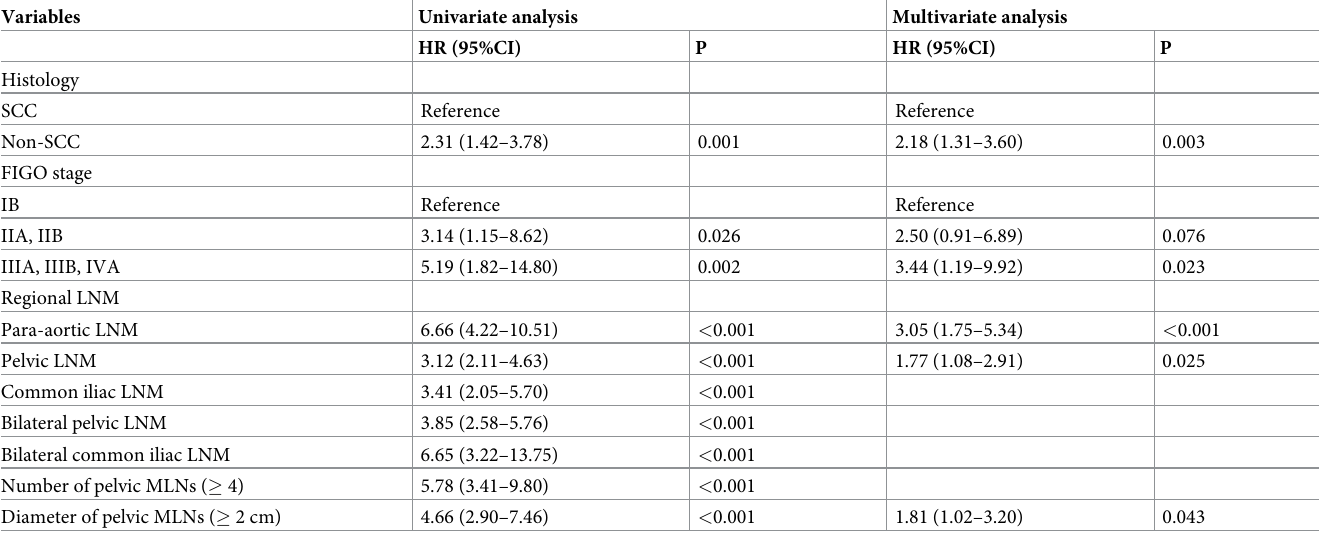
Table 4. Univariate and multivariate analysis for local